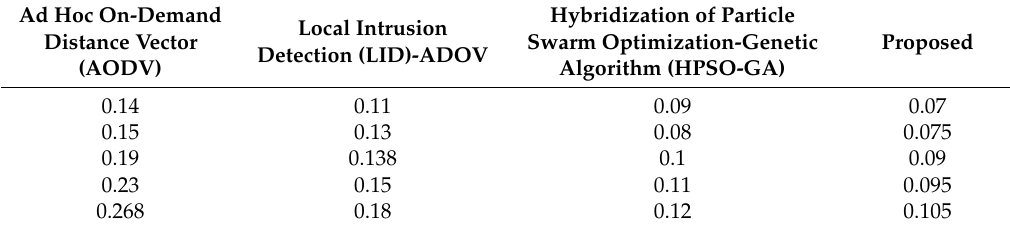
Table 8. The average delay(s).evaluation